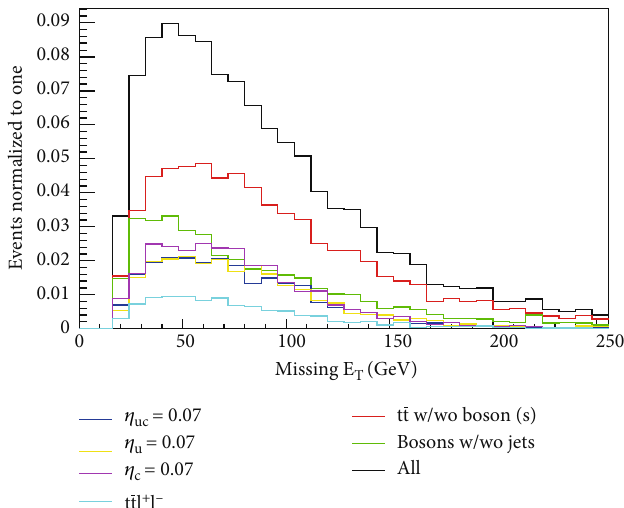
Figure 12: Neutrinos are the main source of missing energy of the interaction. Here, we have two neutrinos coming from W ± decay. Thus, histogram gives a peak about 40-50GeV and boosted too which are in complete consistency with our expectations.